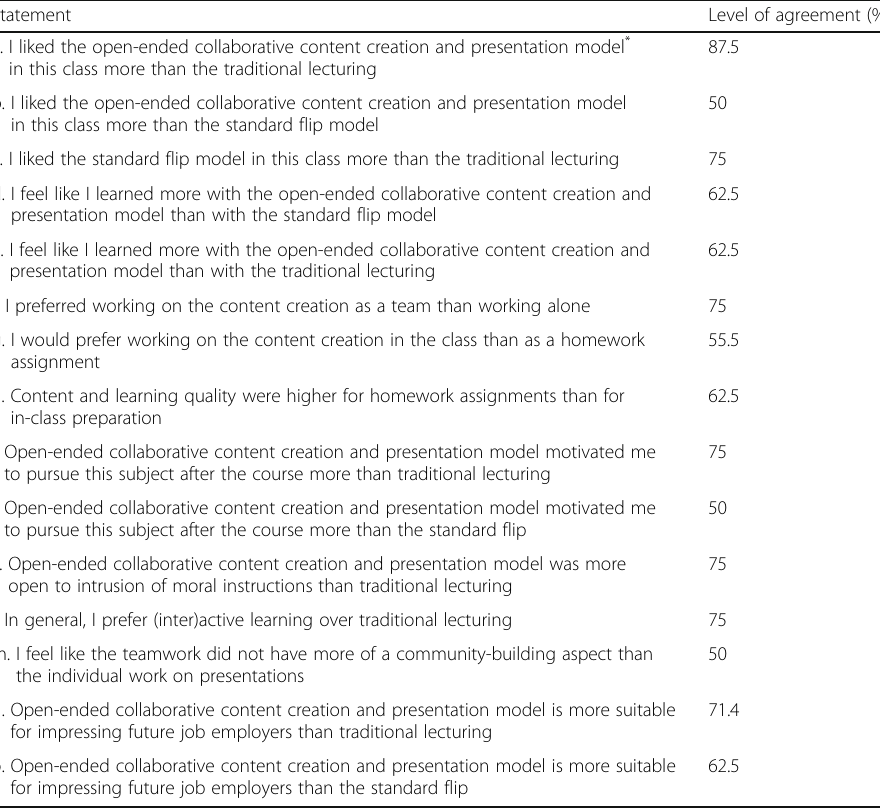
Table 2 Statements from the survey on the perception of learning using different teaching models with the level of agreement ≥